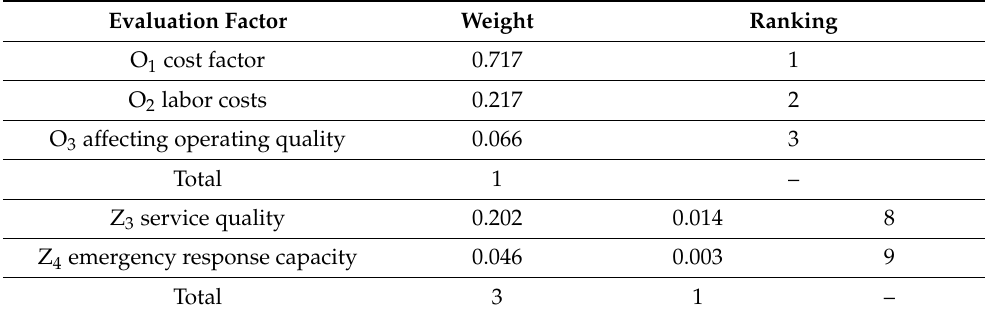
Table 6. The weight and ranking of evaluation factors in the 2nd layer with four lines as an example. Evaluation